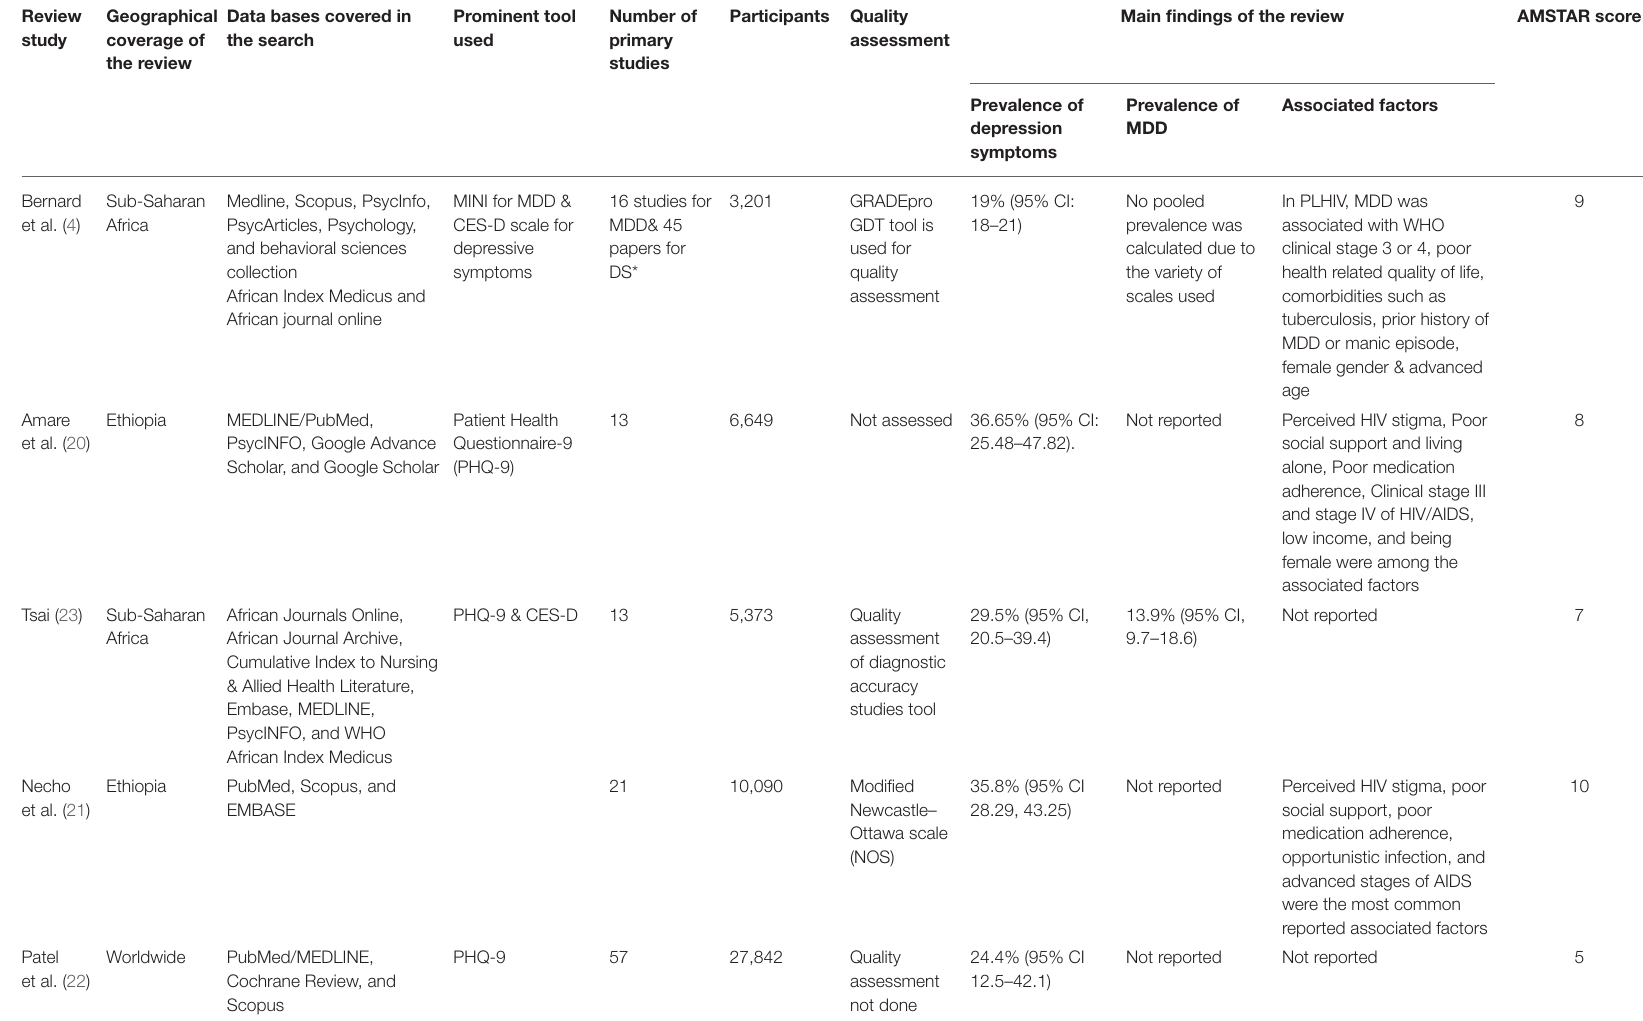
TABLE 1 | Summary of systematic reviews conducted on depression among HIV/AIDS patients included in this systematic review of reviews ( N =